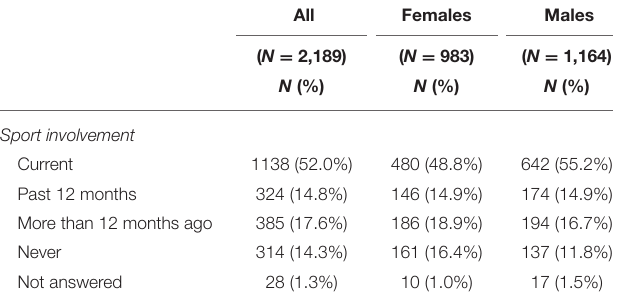
TABLE 2 | Summary of involvement in organised sport.